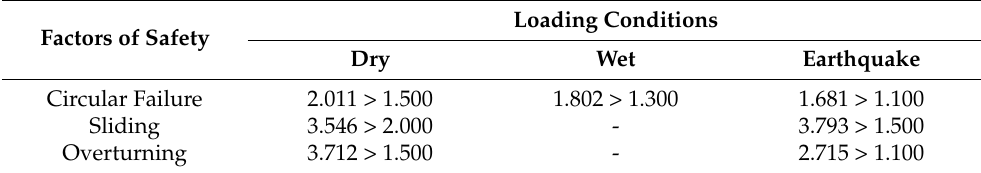
Figure 2. Design of RC retaining wall and RSR: ( a ) originally designed RC retaining wall; ( b ) RSR design. Table 2. Results of stability analysis [24].